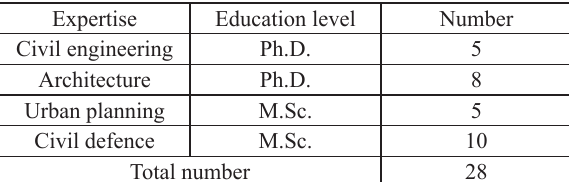
Table 1. Expert community